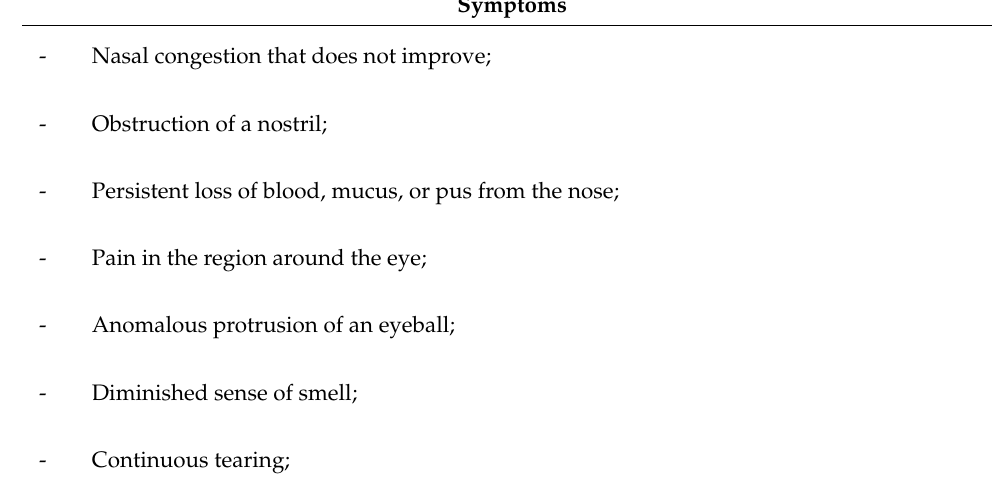
Table 3. Sinonasal neuroendocrine tumors: common